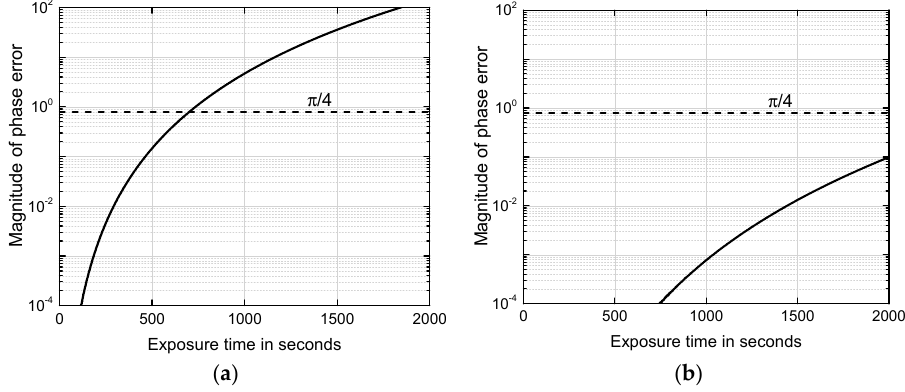
Figure 13. Phase error with range expansion up to ( a ) 4th order and ( b ) 6th order.